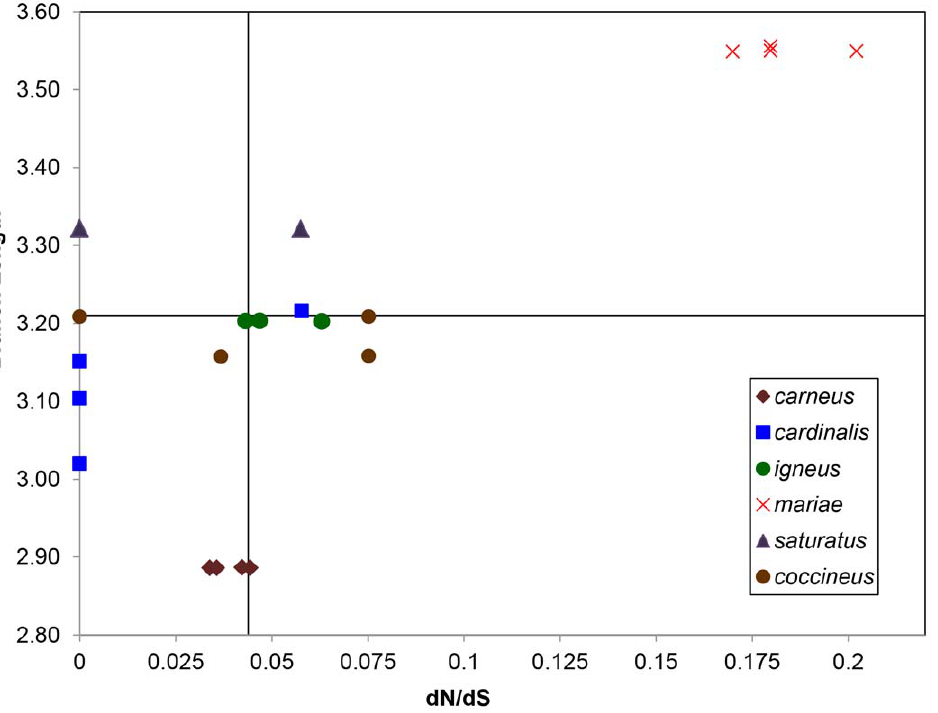
Figure 6. Mitochondrial DNA nonsynonymous/synonymous substitution rate ratio plotted against lineage branch length. Results for multiple haplotypes per lineage are shown. The median branch length is represented by the horizontal line and median dN/dS is represented by the vertical line. Branch lengths were estimated from the distance to common outgroup, Cardinalis sinuatus .